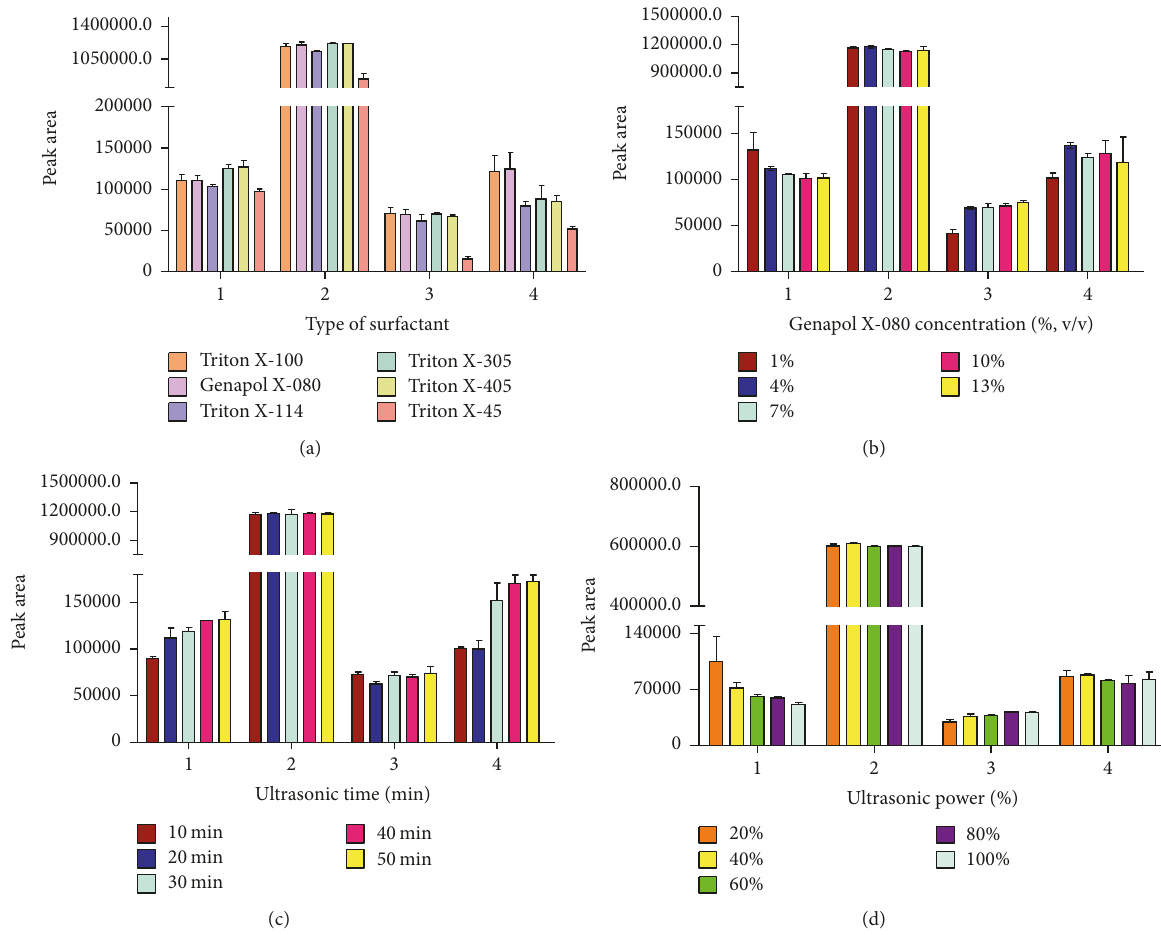
Figure 3: Effect of some parameters of ultrasonic assisted micellar extraction on the extraction effect of 4 components: (a) type of surfactant; (b) Genapol X-080 concentration (%, v/v); (c) ultrasonic time (min); (d) ultrasonic power (%). 1, gallic acid; 2, bergenin; 3, quercitrin; 4,